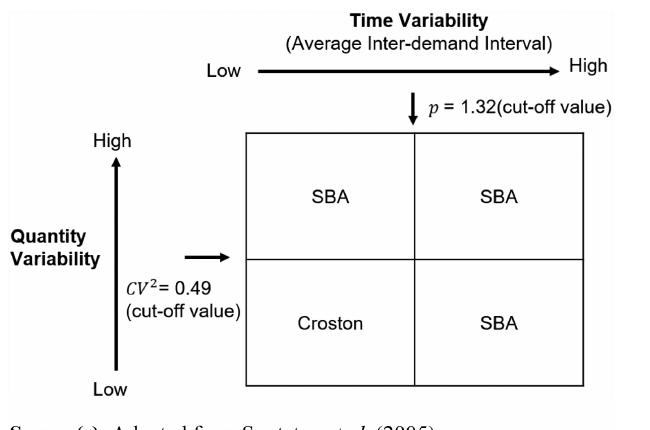
Figure 4. Forecasting technique for demand